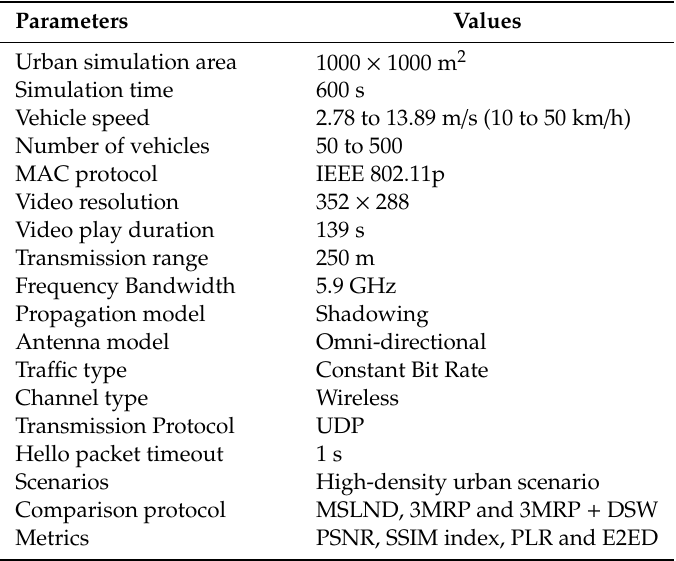
Table 1. Simulation